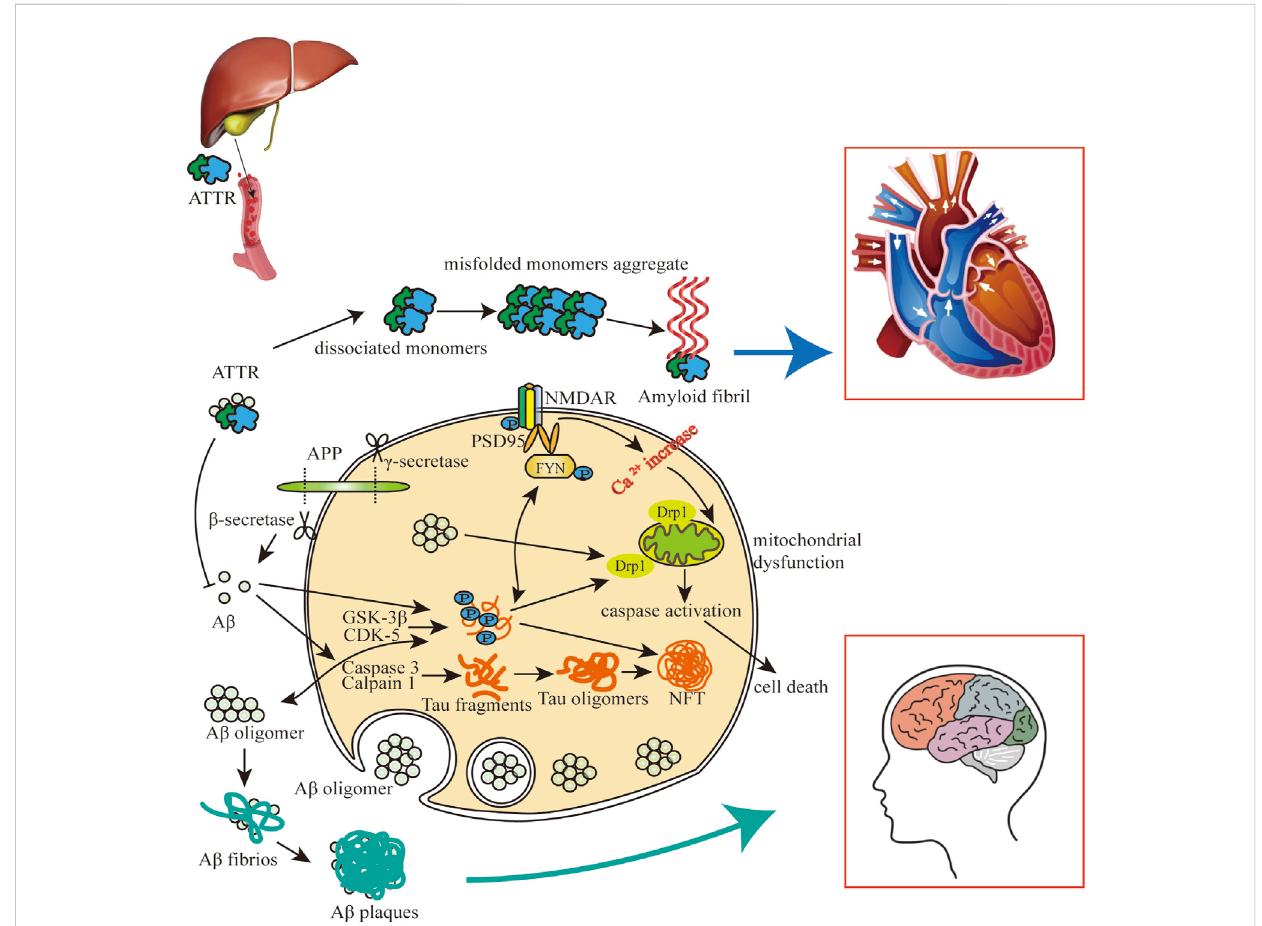
FIGURE 1 The impact of A β -tau-ATTR on AD/CAA and CA. A β and tau can enter cells and their intracellular interaction can cause mitochondrial dysfunction andbrain/heartcelldeath.HighlyphosphorylatedtaupromotesextracellularaggregationofA β ,andextracellularaggregationofA β andATTRcontributes toamyloidosisinheartandbrain.A β plaquesandNFTsmainlyparticipatedinthepathologyofCAAandAD,andATTRamyloid fi brilsaremainlyinvolvedin the pathology of CA.